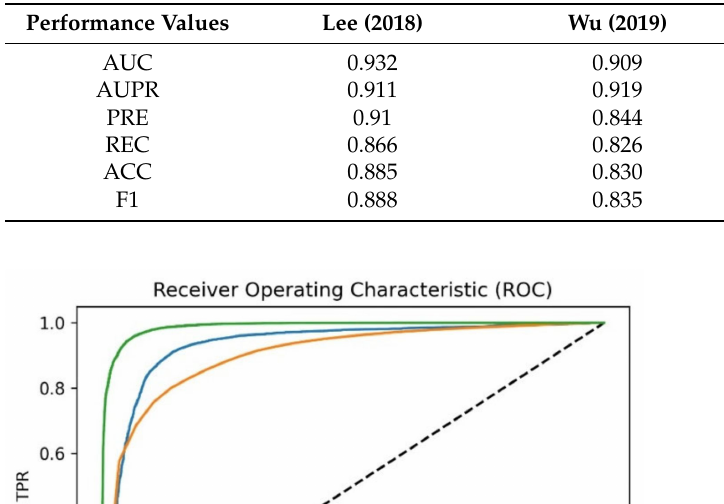
Table 5. Performance of our model compared with Lee’s and Wu’s methods.